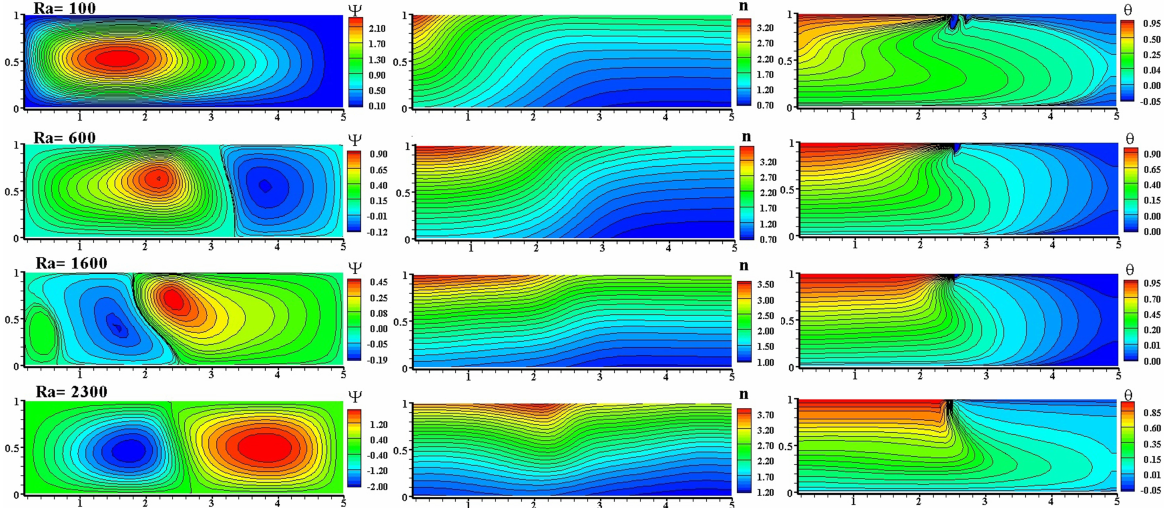
Figure 5. Case 3. From left to right, streamlines, microorganisms concentration and dimensionless temperature contours. For Sc = 1, Pe = 1, Ra T = 1708 and bioconvective Ra for 100, 600, 1600 and 2300.